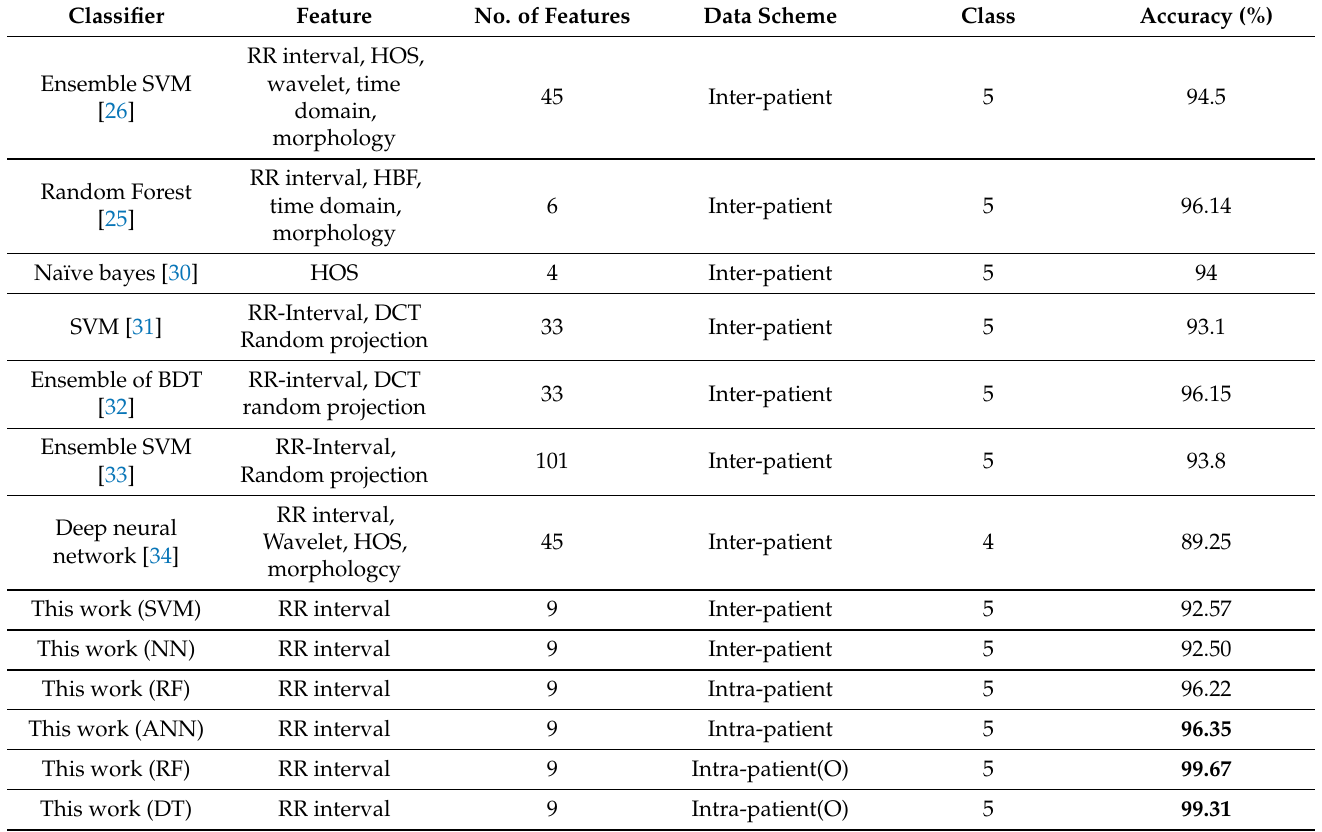
Table 17. Works comparison following AAMI